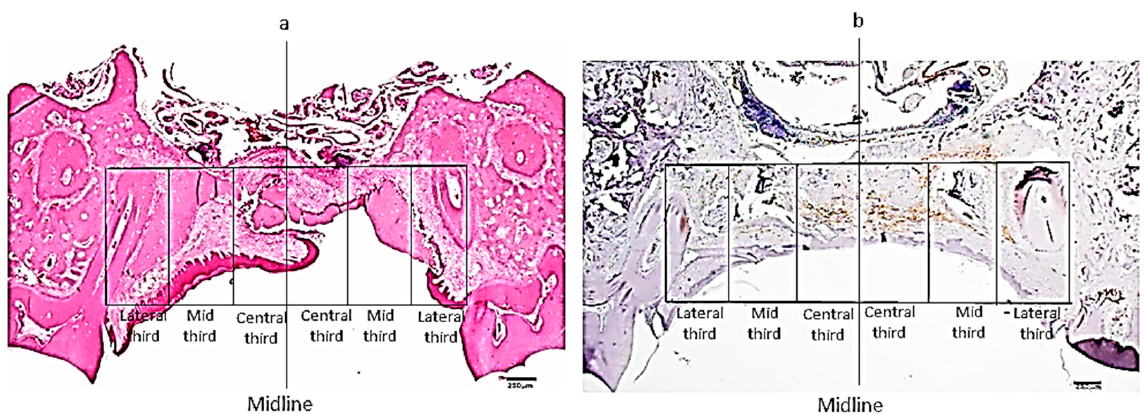
Figure 2. Representative photomicrographs of the wound region in which histometric measurements were made for assessing the degree of inflammation on hematoxylin and eosin-stained slides ( a ) and density of α -SMA-stained myofibroblasts ( b ), ( a , b )—original magnification ×20). Scale bar = 250 µm.